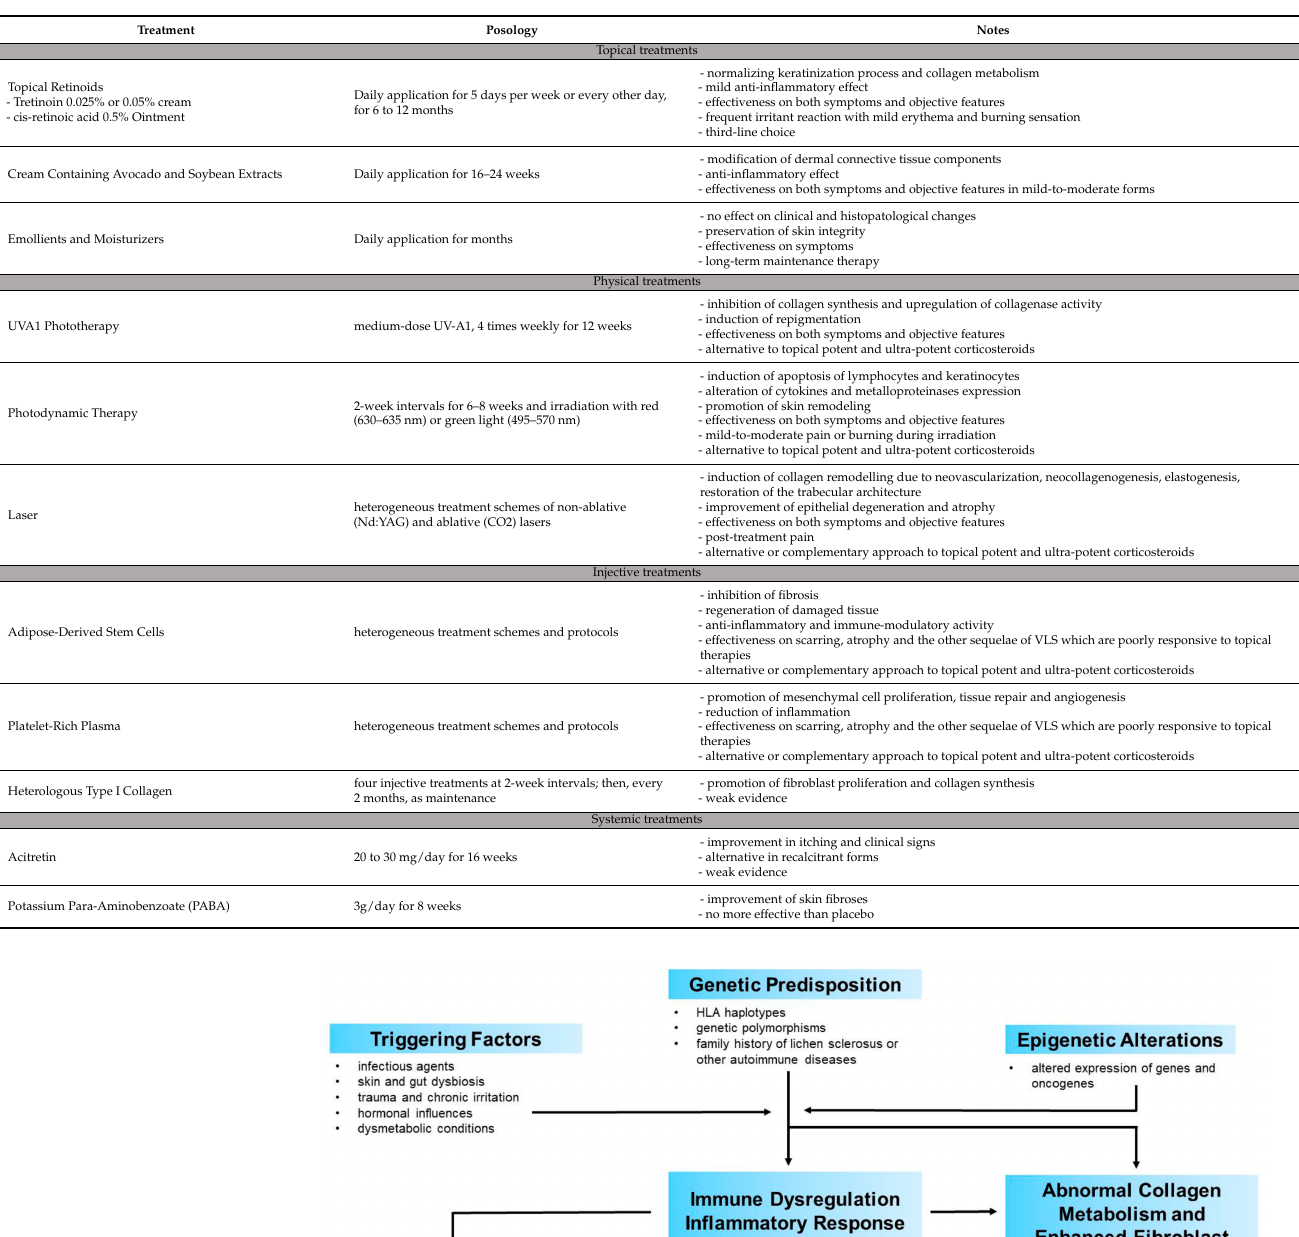
Table A2. Treatments mainly acting on abnormal fibroblast and collagen metabolism.